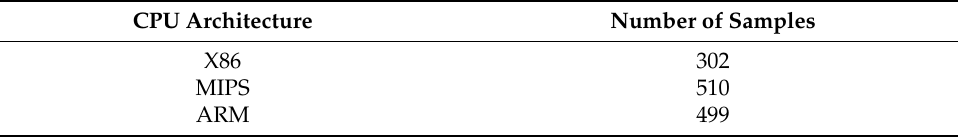
Table 3. CPU architecture per number of IoT botnet samples.